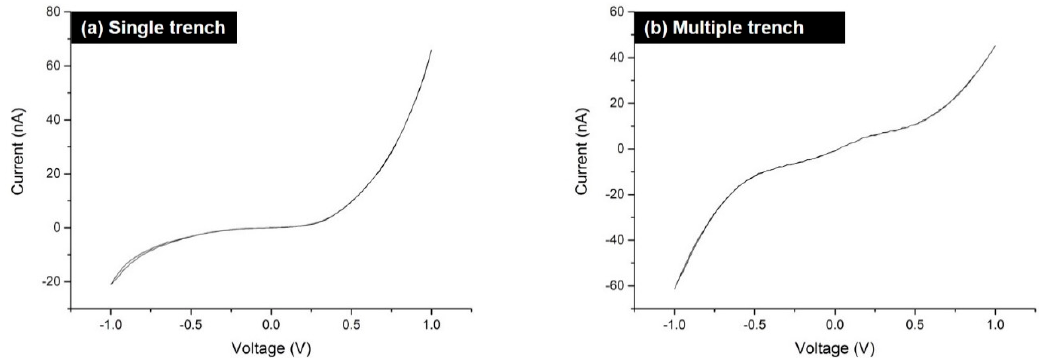
Figure 5. I - V curves of contacted WO 3 nanowires in ( a ) single trench and ( b ) multiple trenches. See text for further details.